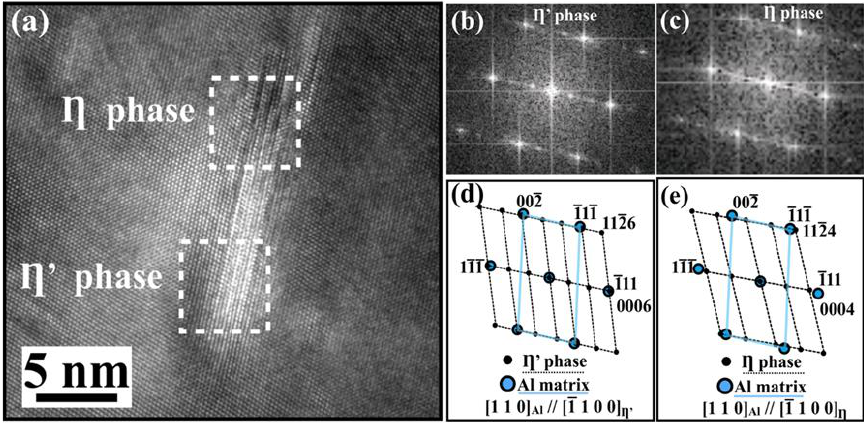
Figure 11. ( a ) TEM micrograph of η (cid:48) to η transformation. ( b , c ) Respective FFT, diffractograms. ( d , e ) The illustrated diffraction patterns.